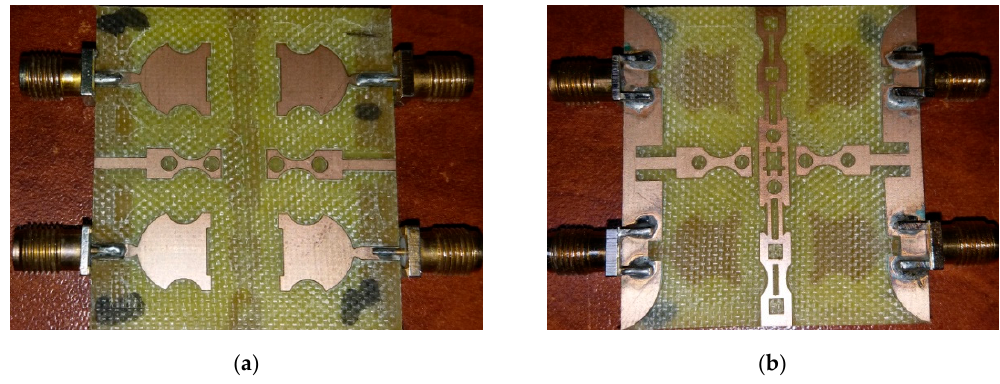
Figure 3. Fabricated UWB-MIMO antenna: ( a ) front view; ( b ) rear view.